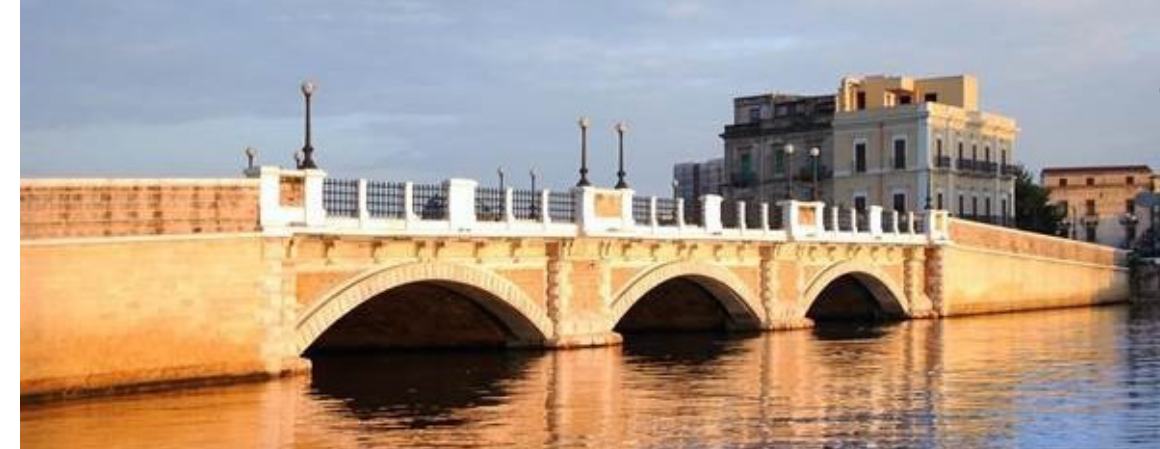
Figure 2: Porta Napoli bridge. View from Mar Piccolo.